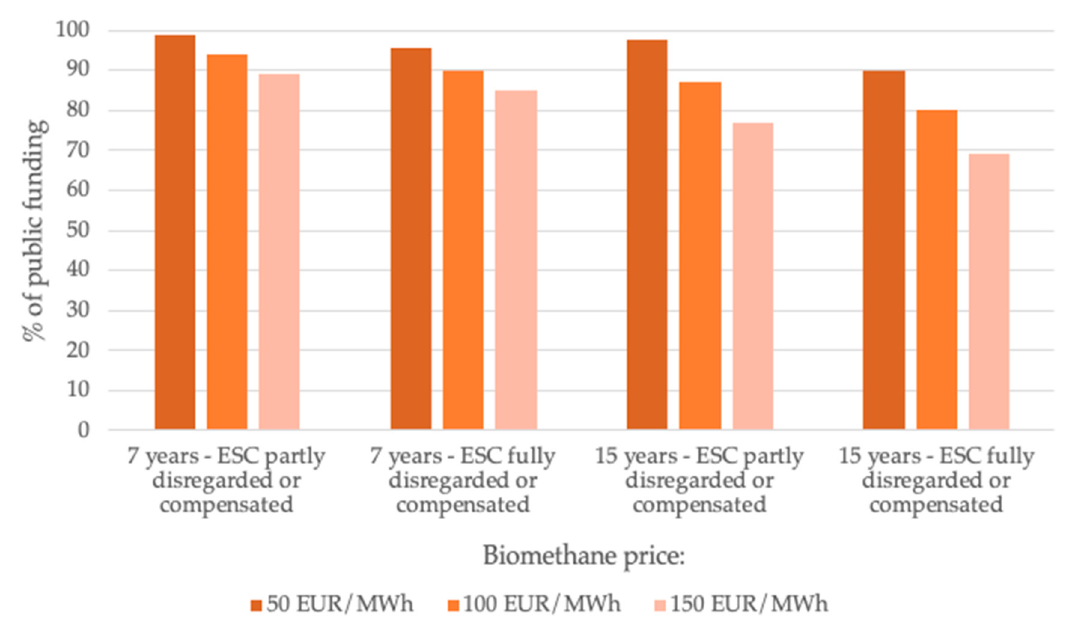
Figure 4. Percentages for public funding of CAPEX for 7- and 15-year-long payback period of a 1 MW el P2M plant focusing only on seasonal energy storage with 1200 operating h/year.